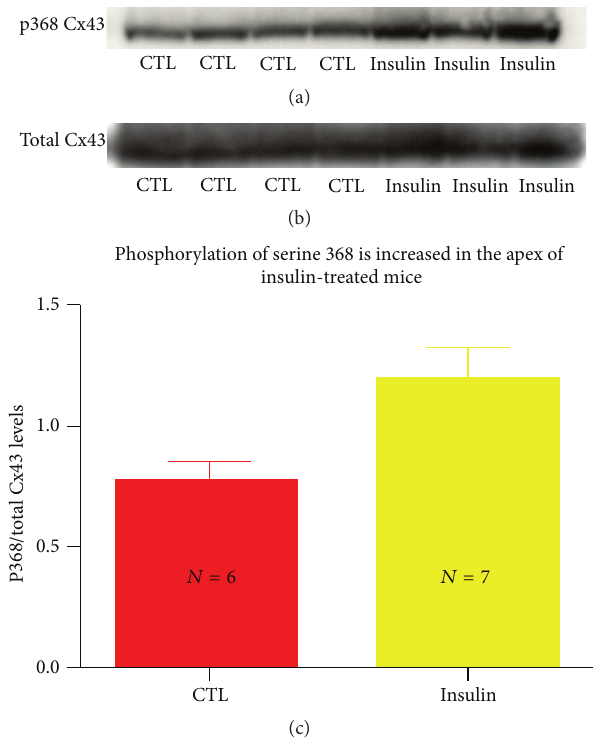
Figure 4: Cx43 phosphorylation at serine 368 is enhanced with insulin administration in the mouse heart. Representative western blot labeling Cx43 phosphorylated at serine 368 (a) and total Cx43 (b) of homogenized ventricles of control mice and those treated with insulin. A significant increase in serine 368/total Cx43 was detected in hearts harvested from insulin-treated animals, 𝑝 < 0.05